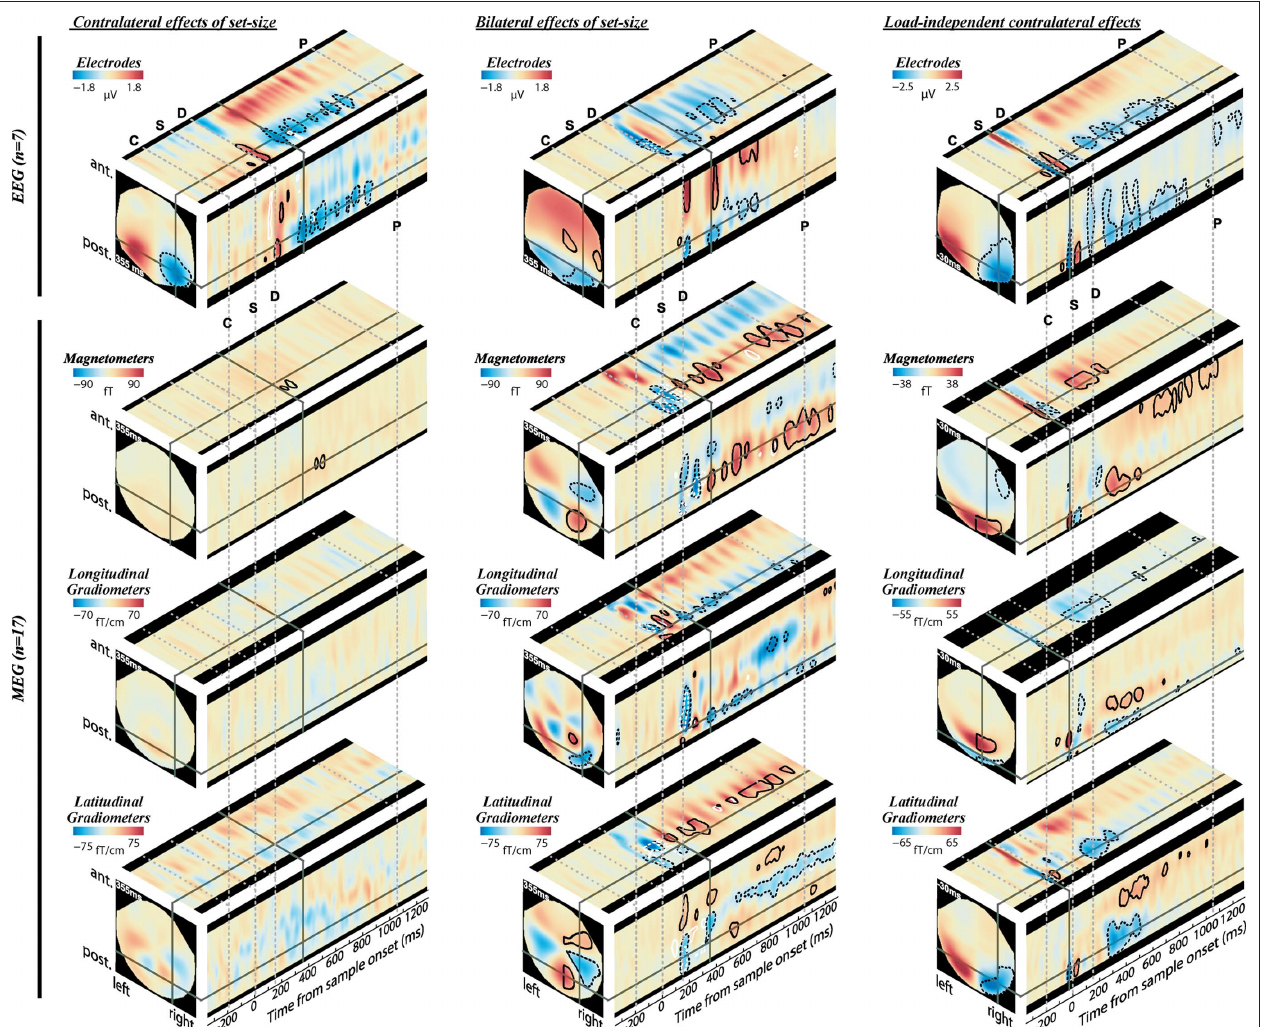
are significantly greater (solid lines) or less (dotted lines) than baseline levels (posterior probability > 0.99). For the left and middle columns, black contours represent the K -weighted contrasts and white contours represent additional contributions to a linear load response. Note that the volumes are symmetric (or anti-symmetric) in the left–right direction and significance contours are confined to the right hemisphere. The onset of the cue, sample, delay, and earliest possible probe are marked by the gray dotted lines, labeled C, S, D, and P,